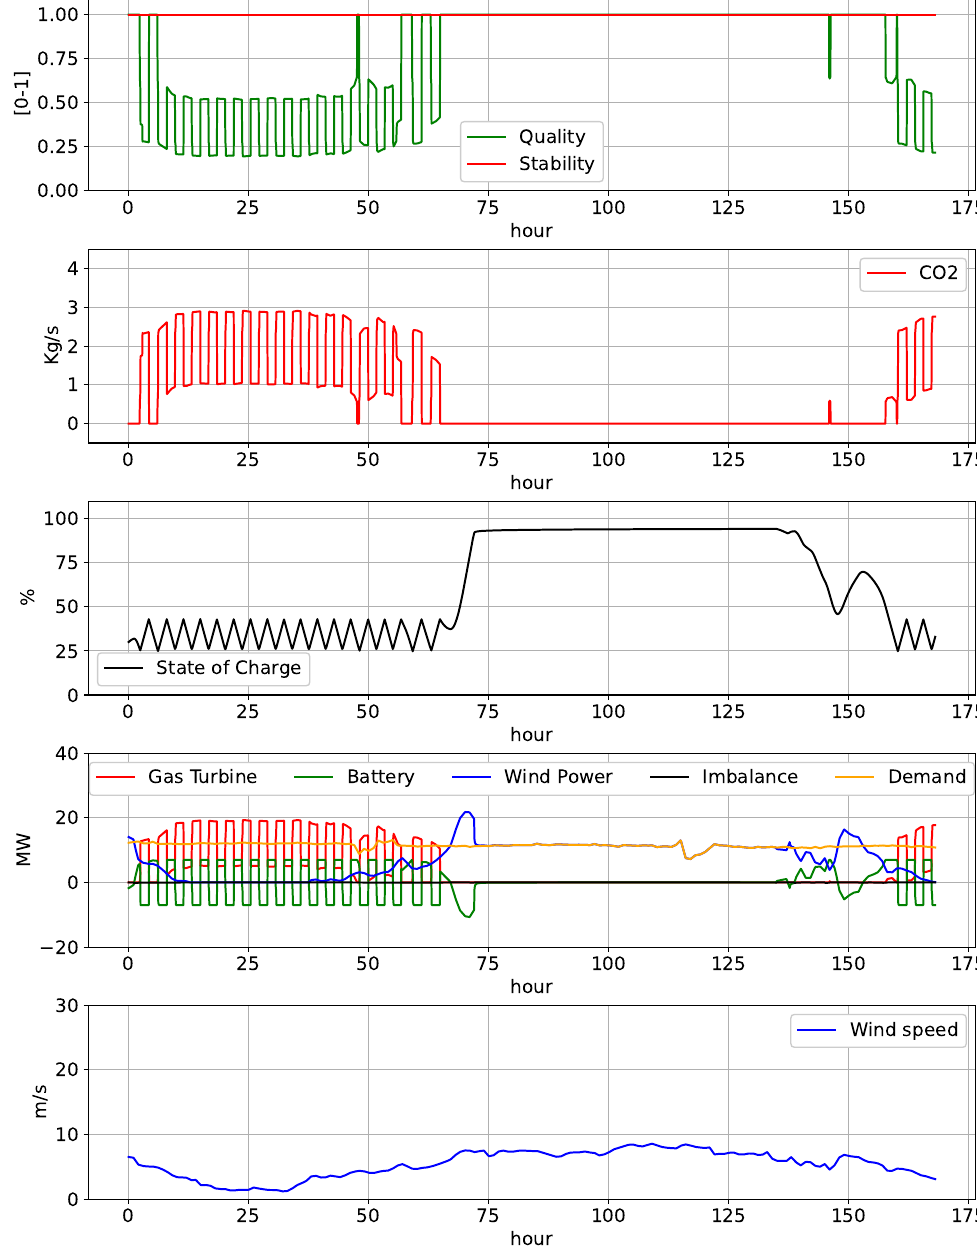
Figure 18. Strategy 1 with low wind speed